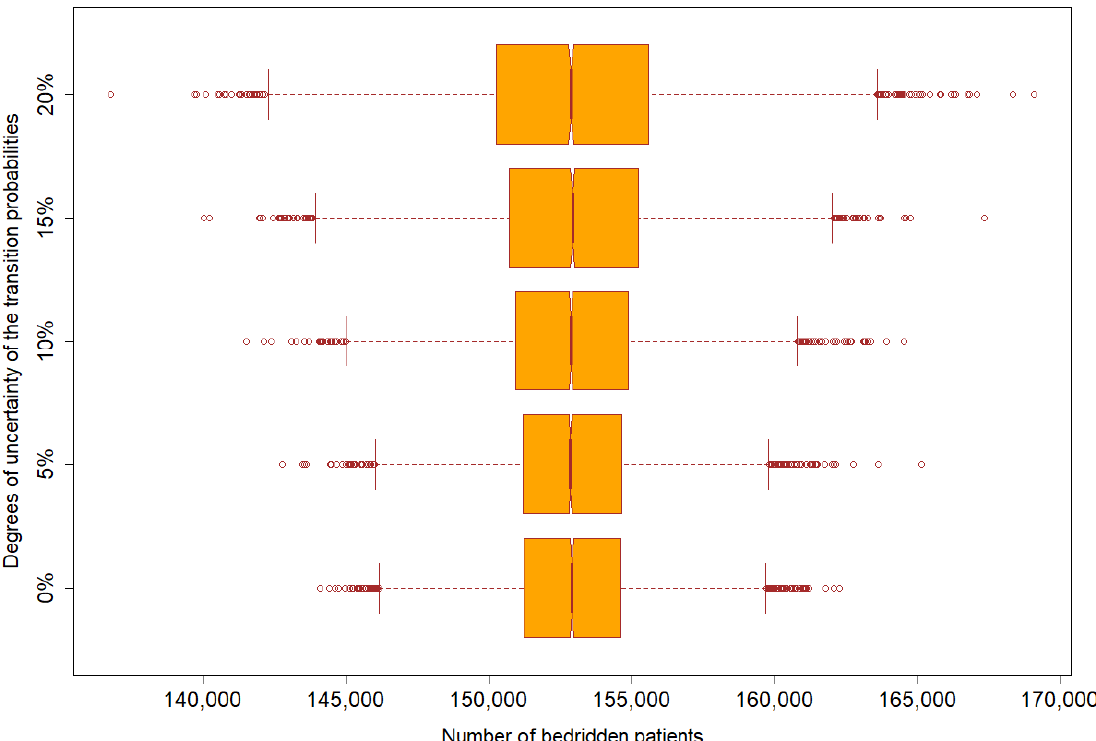
Figure 5. Number of bedridden patients given different degrees of uncertainty of the transition probabilities (scenarios with 5%, 10%, 15%, and 20% changes).